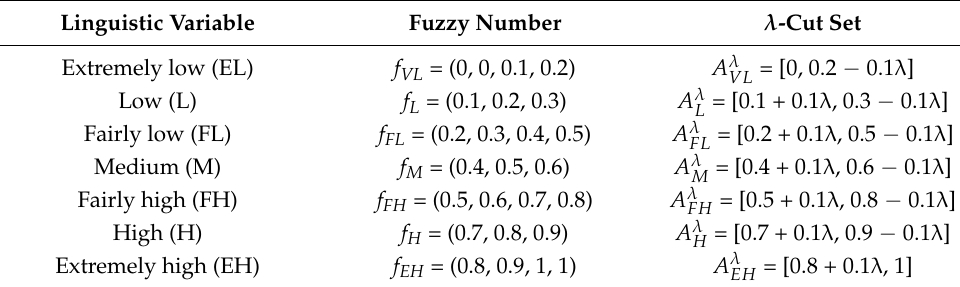
Table 3. The fuzzy number and λ -cut